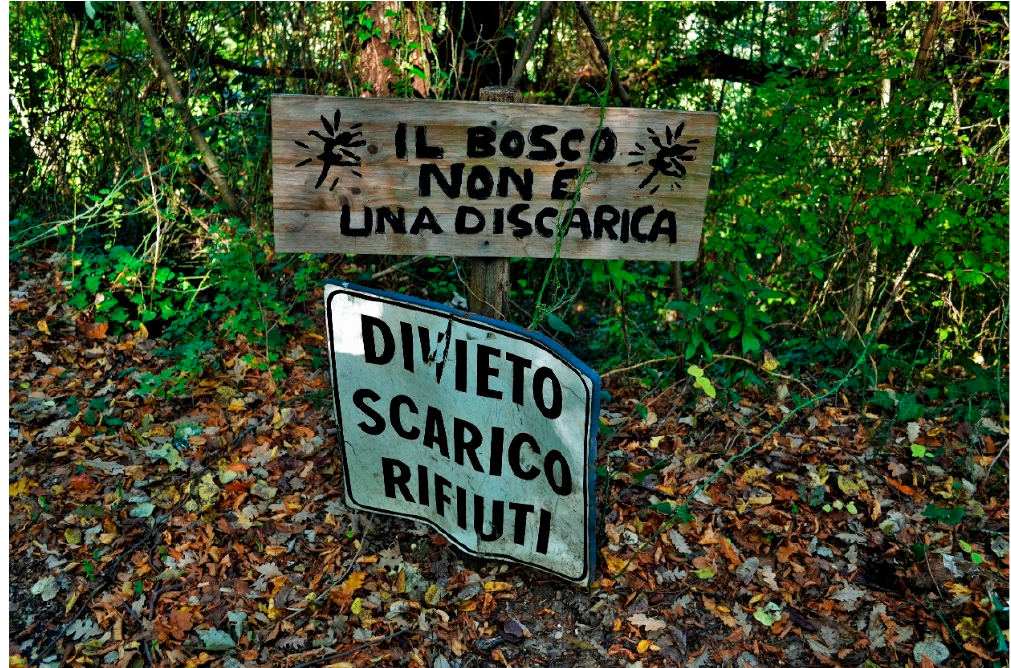
Figure 2. Secondo Avviso (Second warning). 2 Photo by Agricubismo ® .